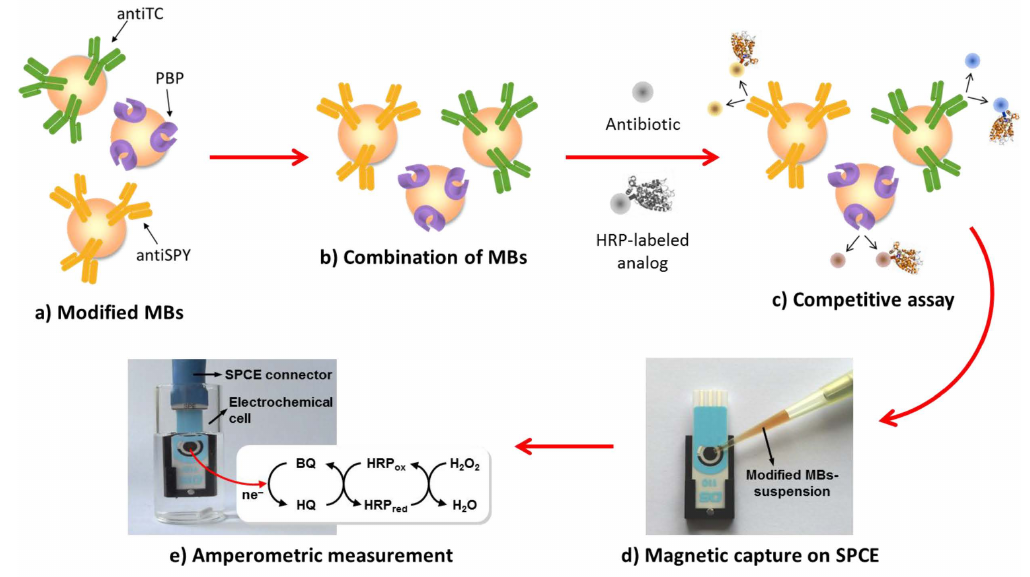
Figure 4. Schematic display of the multi-antibiotics magnetosensor developed. The modified MMPs (MBs in the Figure) ( a ) are commingled together ( b ) and incubated with the sample in the presence of a fixed amount of the three enzyme-labeled analogs, thus establishing a direct competitive assay ( c ), the MBs are then captured on the surface of a SPCE inserted on the magnet holding block ( d ) and SPCE-magnet holding block immersed in the electrochemical cell ( e ). Reprinted from Ref. [57] with